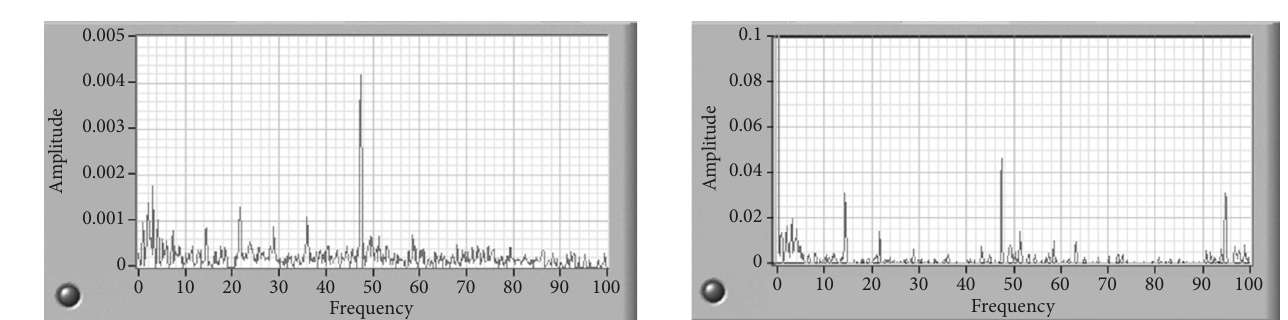
Figure 6: Filtered FFT signal of the force (kg), corresponding to 0 mm and 60